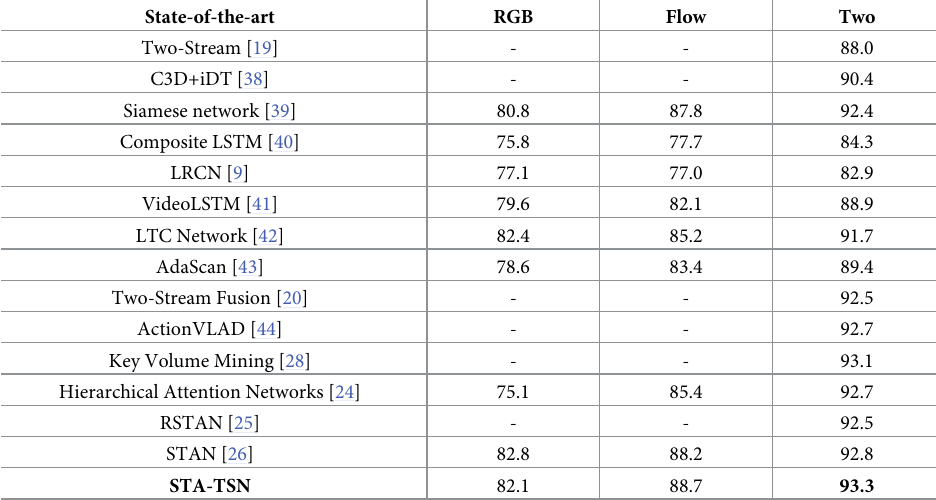
Table 4. Comparison with the state-of-the-art on UCF101 (average over three splits).